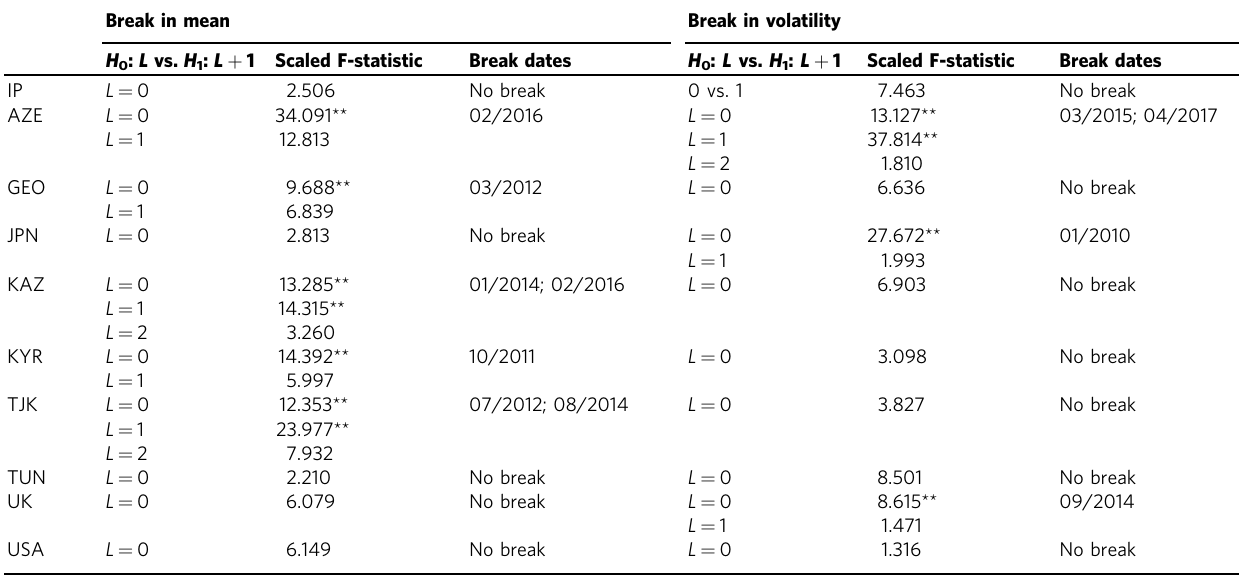
Table 3 Structural breaks test for mean and volatility of beef price returns. Break in